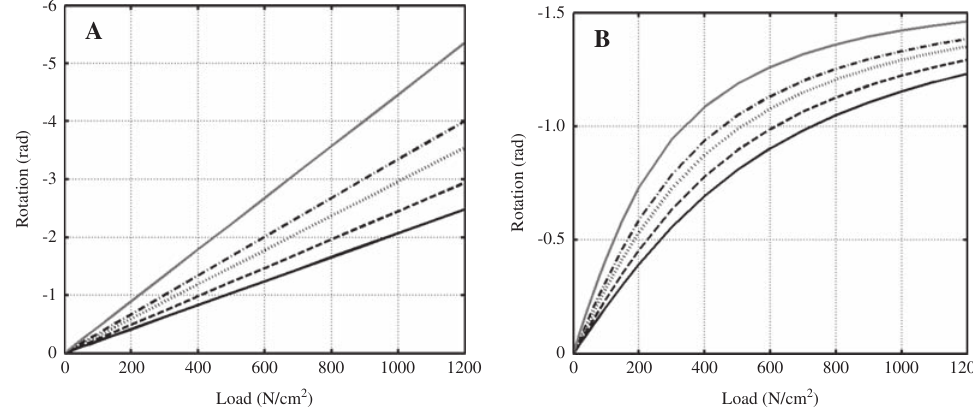
Figure 9 Load-tip rotation curves for various values of the power-law exponent. ( – – – – ) Full ceramic, ( – – – ) k = 0.3, (------) k = 1, ( – – – ) k = 3, ( – – – – ) full metal, (A) linear case, (B) non-linear